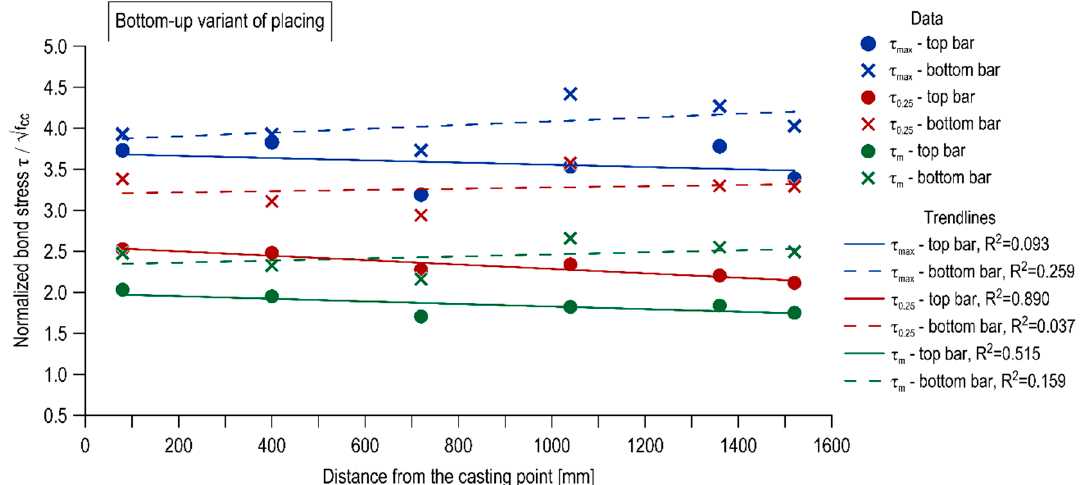
Figure 12. Effect of distance from casting point in the bottom-up variant of placing. Figure 12. E ff ect of distance from casting point in the bottom-up variant of